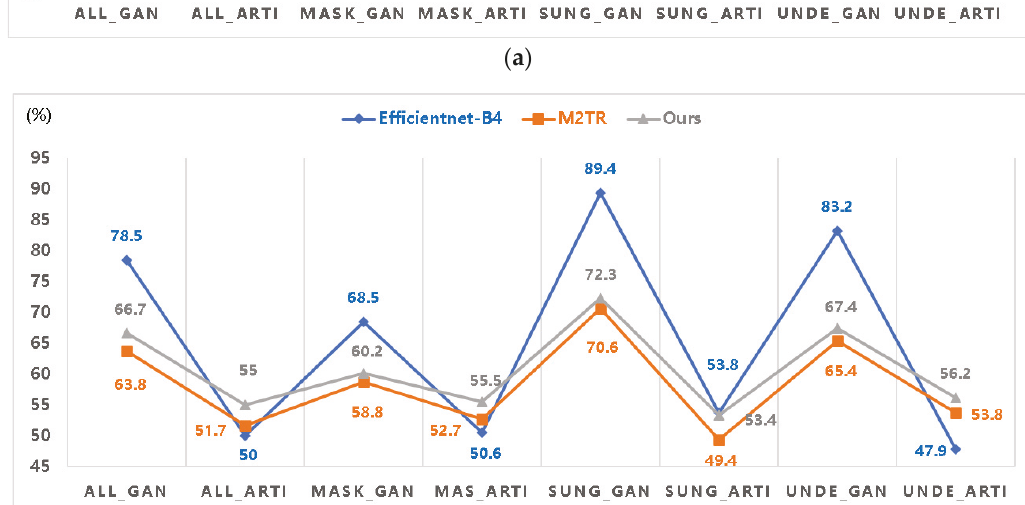
Figure 6. The line chart of the comparison in ACC and AUC. ( a ) The line chart of the comparison between GAN-generated and artificial datasets in ACC (%). ( b ) The line chart of the comparison between GAN-generated and artificial datasets in AUC (%).